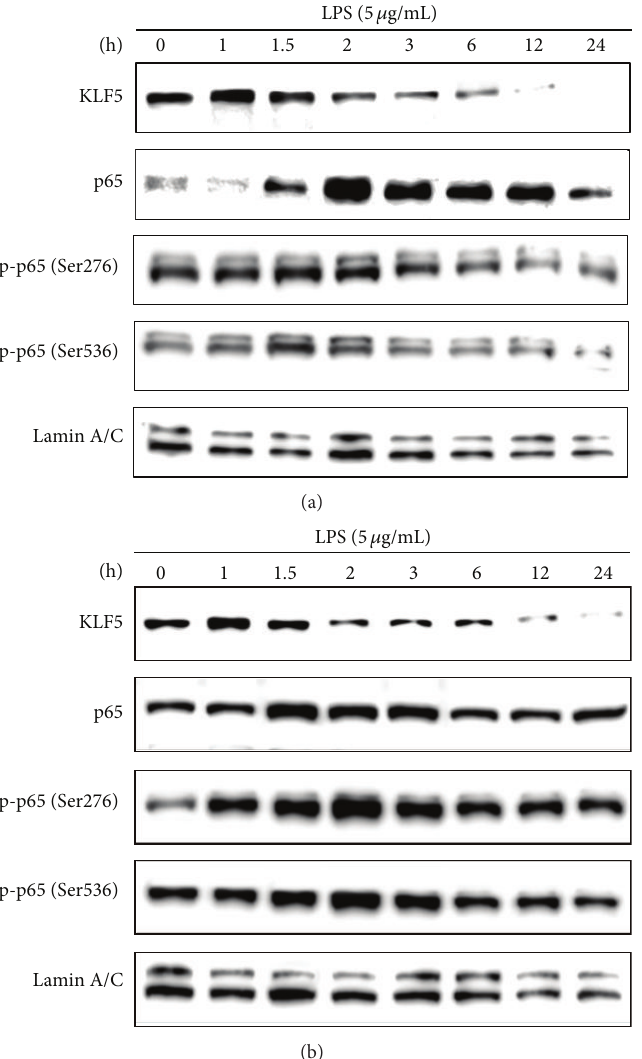
Figure 2: Effects of lipopolysaccharide (LPS) exposure on Kr¨uppel-like factor 5 (KLF5) and nuclear factor-kappaB subunit protein expression in human bronchial epithelial cells. Cells from the (a) HBEC and (b) BEAS-2B lines were incubated with LPS (5 𝜇 g/mL) for various durations, and KLF5, p65, phospho-p65 (Ser276), and phospho-p65 (Ser536) protein expression were evaluated using western blotting. The time to peak intensities of KLF5, p65, Ser276, and Ser536 phosphorylation differed slightly. Data were obtained from 3 independent